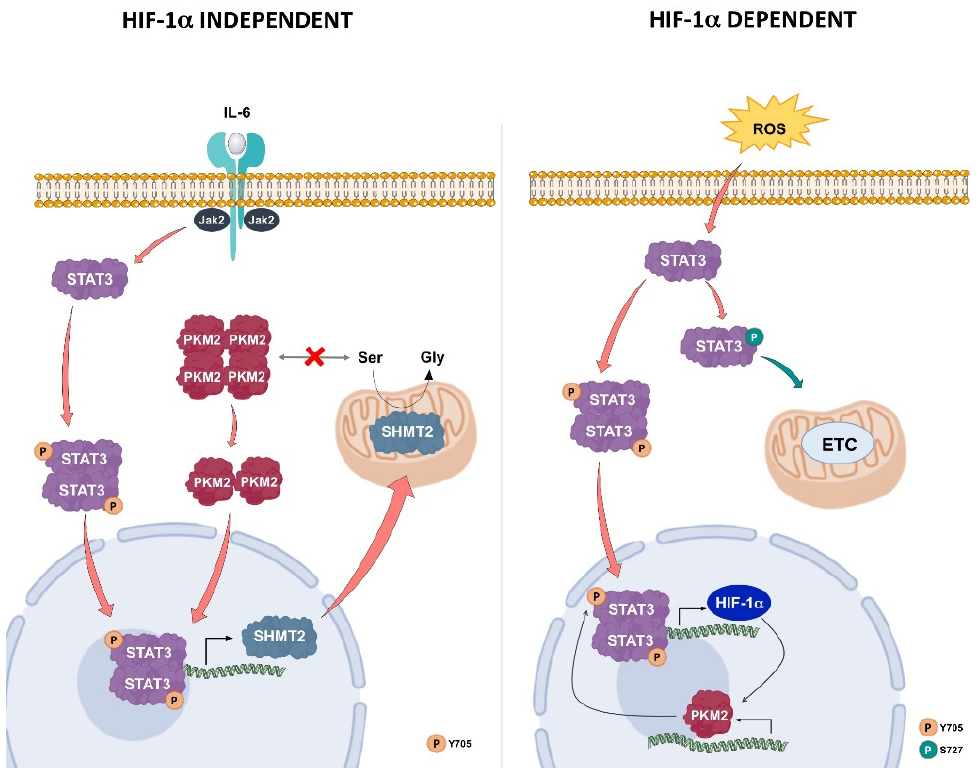
Figure 11. Models of protein loops involving STAT3 and PKM2.